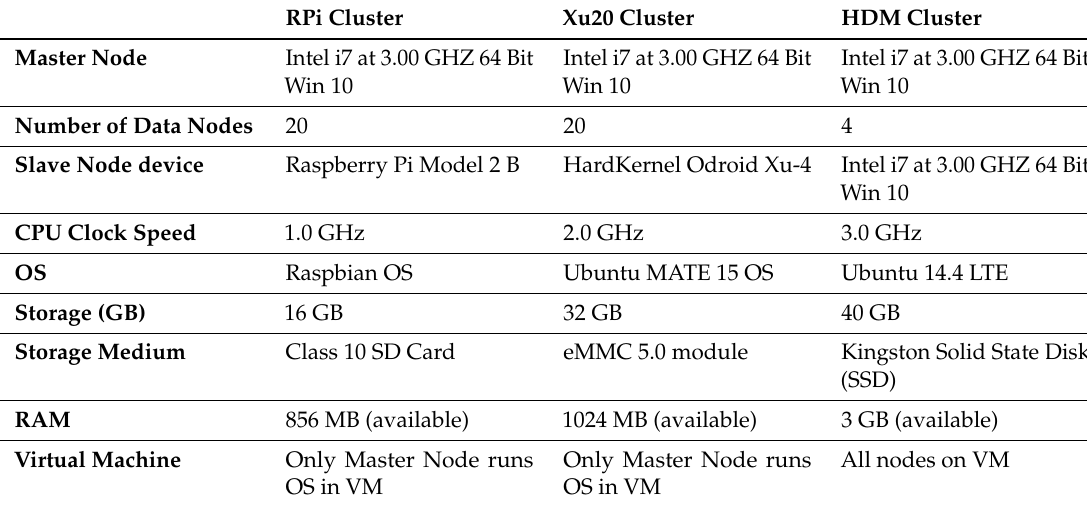
Table 2. Comparison of various features of the